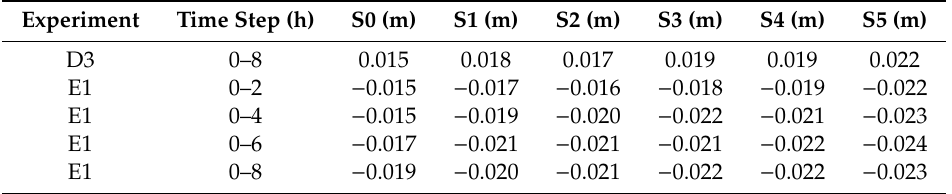
Table 4. Mean elevation change for 1-m long sections along the flow path for the test runs D1 and E1. Experiment Time Step (h)